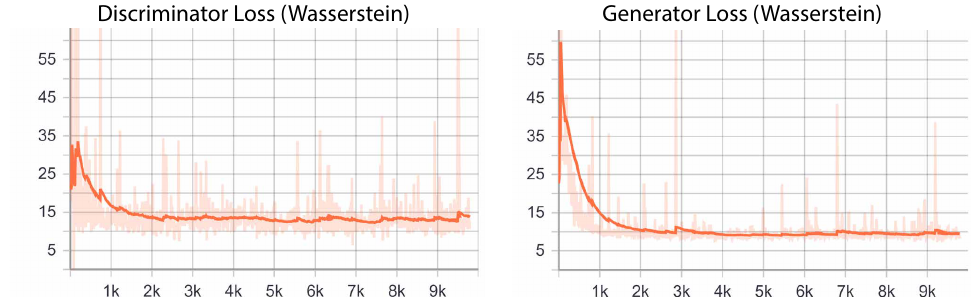
Figure 8. Plots of discriminator and generator loss trained using the Wasserstein loss functions with γ = 10.The x axis shows number of training steps. The darker lines in the plots show the exponential moving average of the actual values represented by the lighter